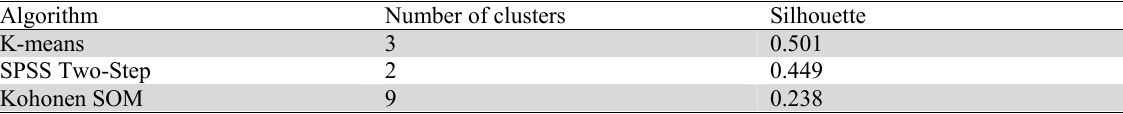
Comparison of the clustering algorithms for scenario 8 in situation 1 Algorithm